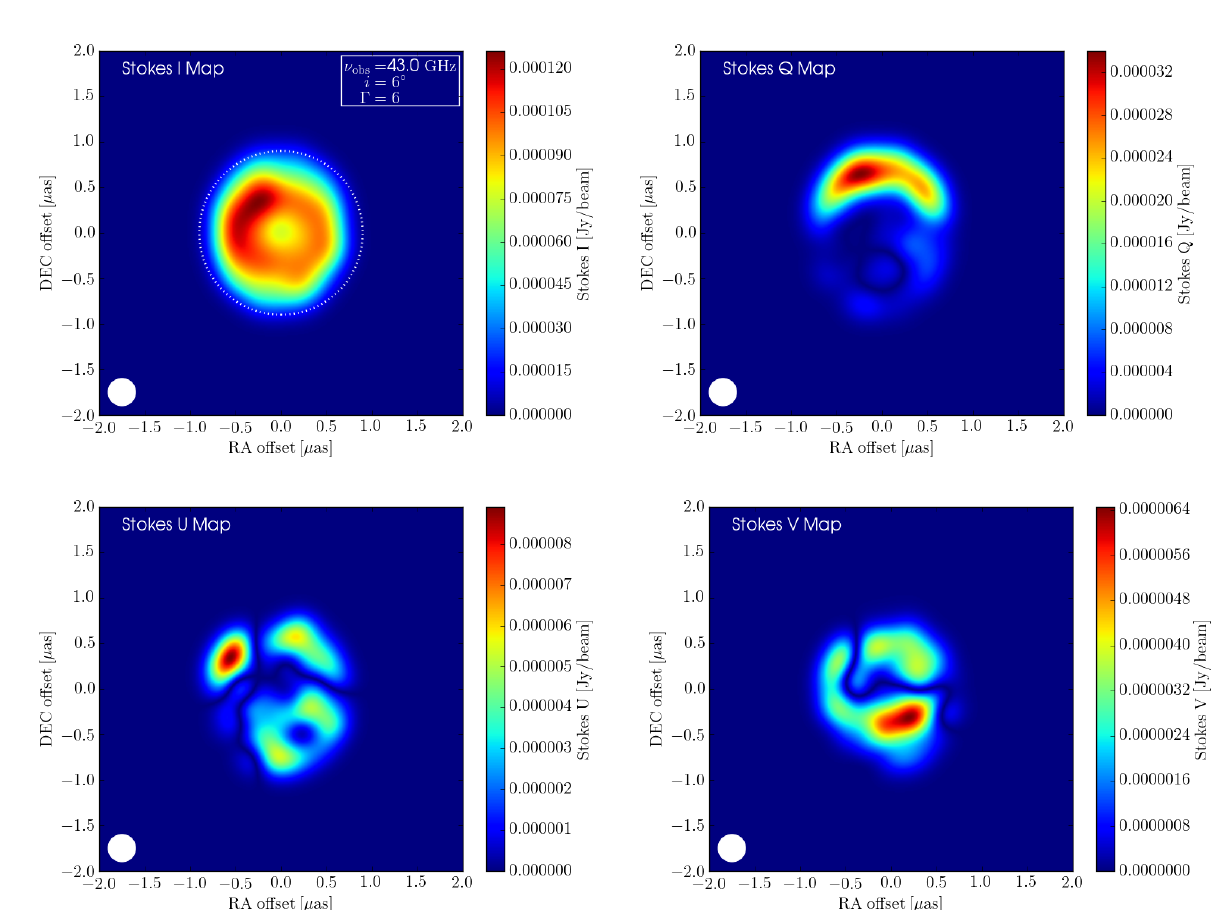
Figure 5. ( Upper left )—Stokes I emission map at an observing frequency of 43 GHz. The white dashed circle defines an arbitrary region within which I compute fractional circular ( m c ) and linear ( m l ) polarization (presented in Figure 6). ( Upper right )—Stokes Q emission map. ( Lower left )—Stokes U emission map. ( Lower right )—Stokes V emission map. The above images have all been convolved with the circular Gaussian beam shown in the lower